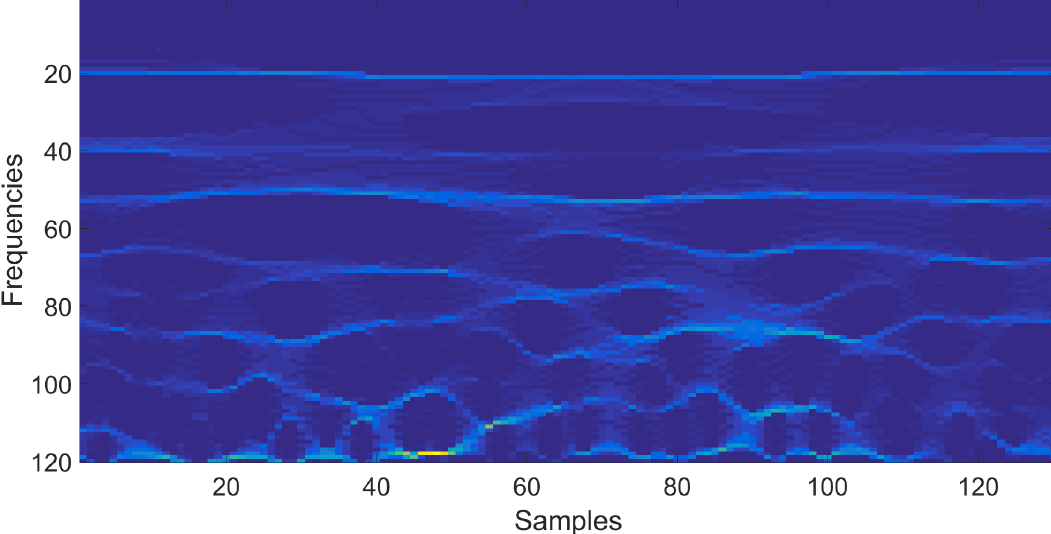
Figure 3. Spectrogram of the synchrosqueezing transform of the digitized signal from the wireless